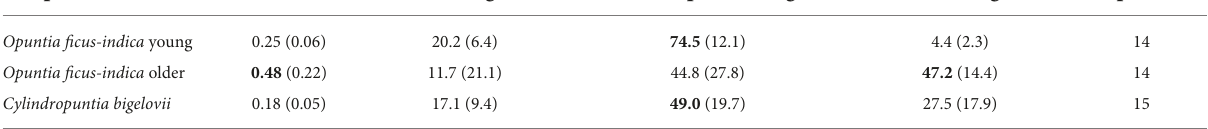
Sample Total strain [/] Elastic range [%] Viscoelastic plastic range [%] Fracture range [%] Sample size N Opuntia ficus-indica